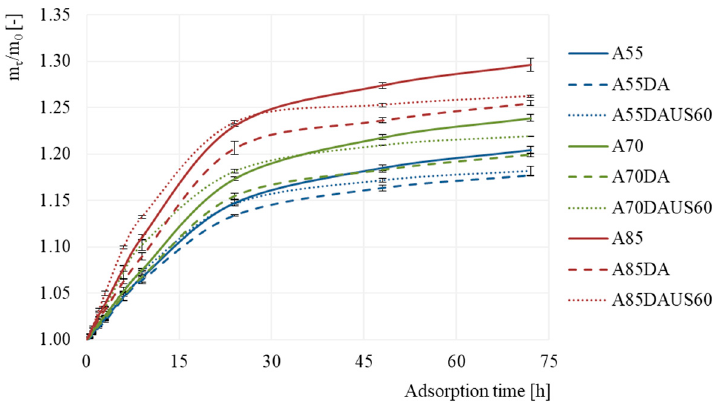
Figure 3. Mass gain depending on the time of moisture adsorption by the dried apples obtained by the convective method with non-dehumidified air dehumidified air, and dehumidified air with ultrasound pretreatment.